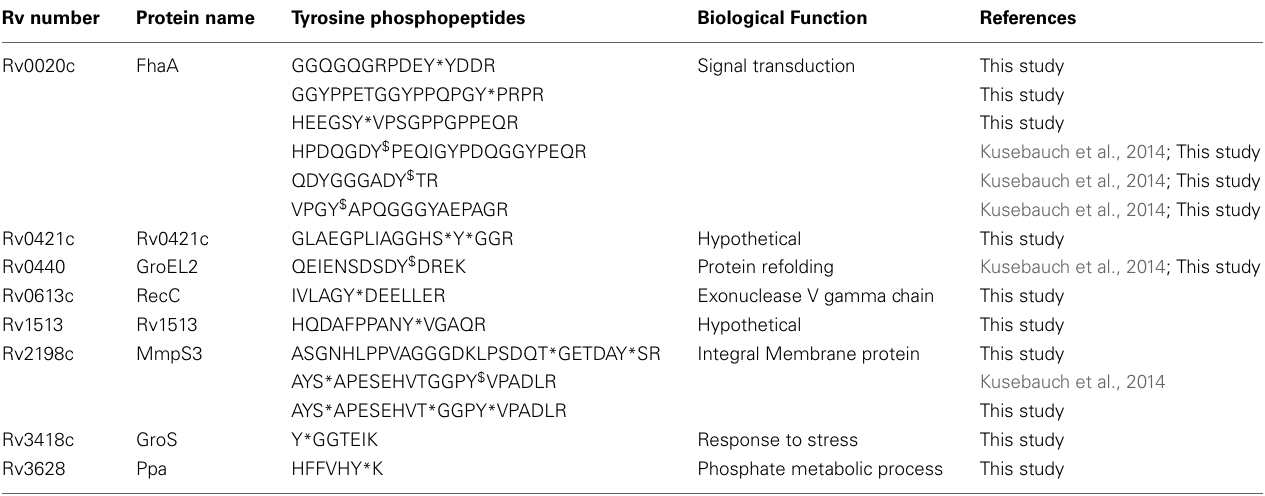
Table 3 | Tyrosine phosphorylation sites identified.